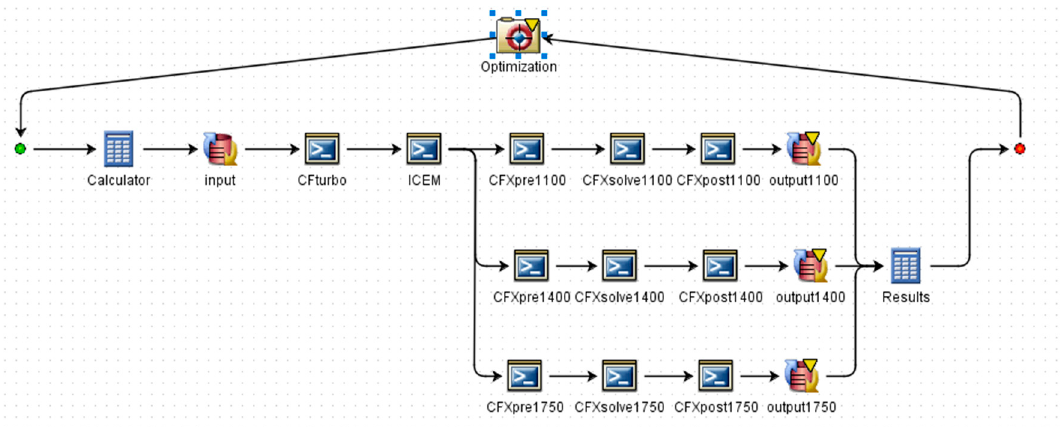
Figure 9. Integrated optimization platform of automotive electronic water pump.